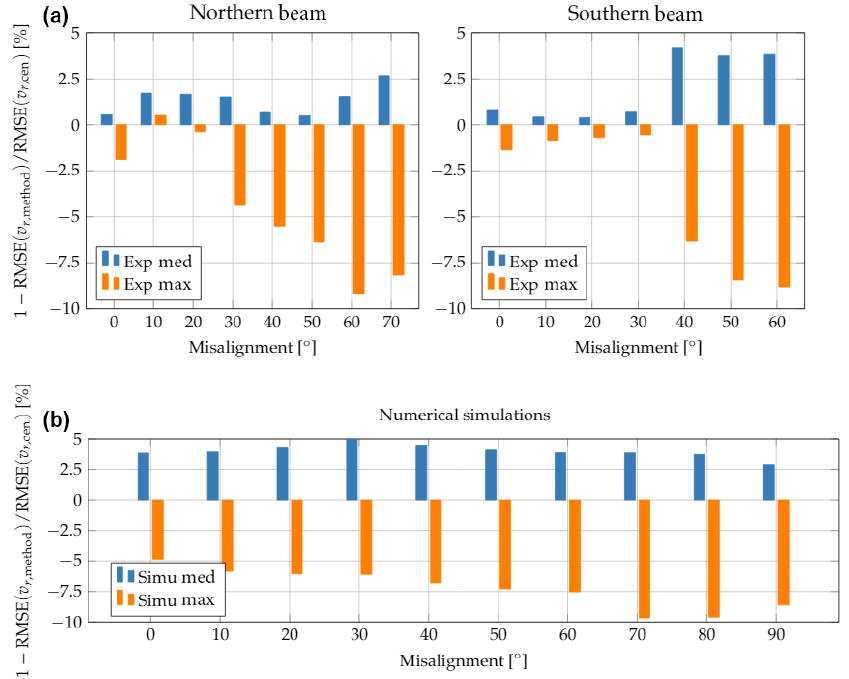
Figure 8. RMSE value for the median and maximum method normalised by RMSE (v r, cen ) for the experimental results ( a ) and the numerical simulations ( b ) using 20 simulations and 2 months of experimental data at a sampling rate of